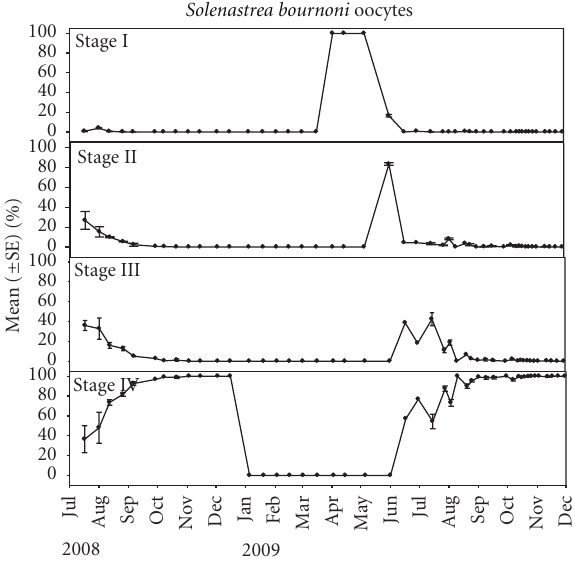
Figure 1: Solenastrea bournoni mean ( ± SE) percentage of oocytes per colony quantified through histological